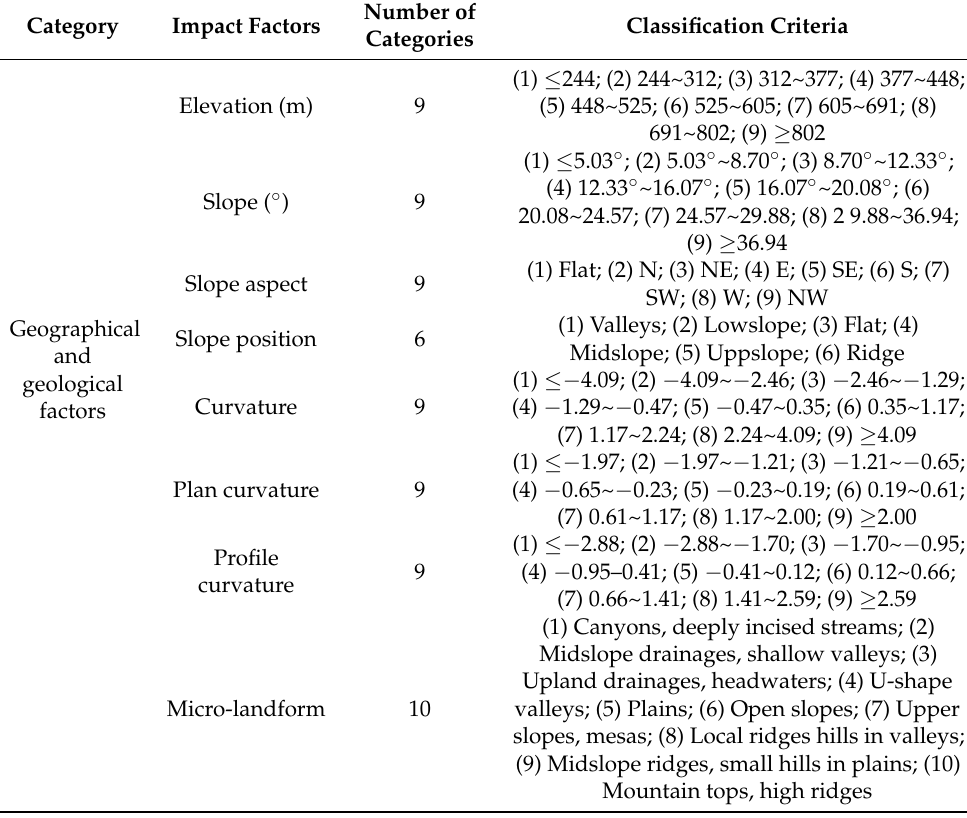
Table 3. Reclassification of impact